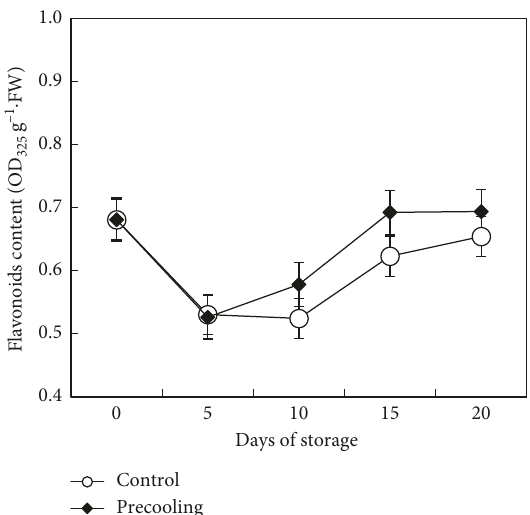
Figure 5: Effects of forced air precooling treatment on flavonoid content.